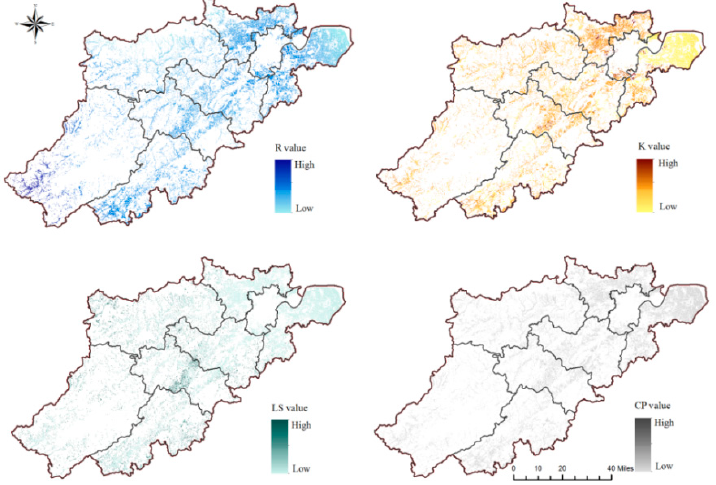
Figure A1. Spatial patterns of the R, K, LS and CP factors of farmland within the study area.